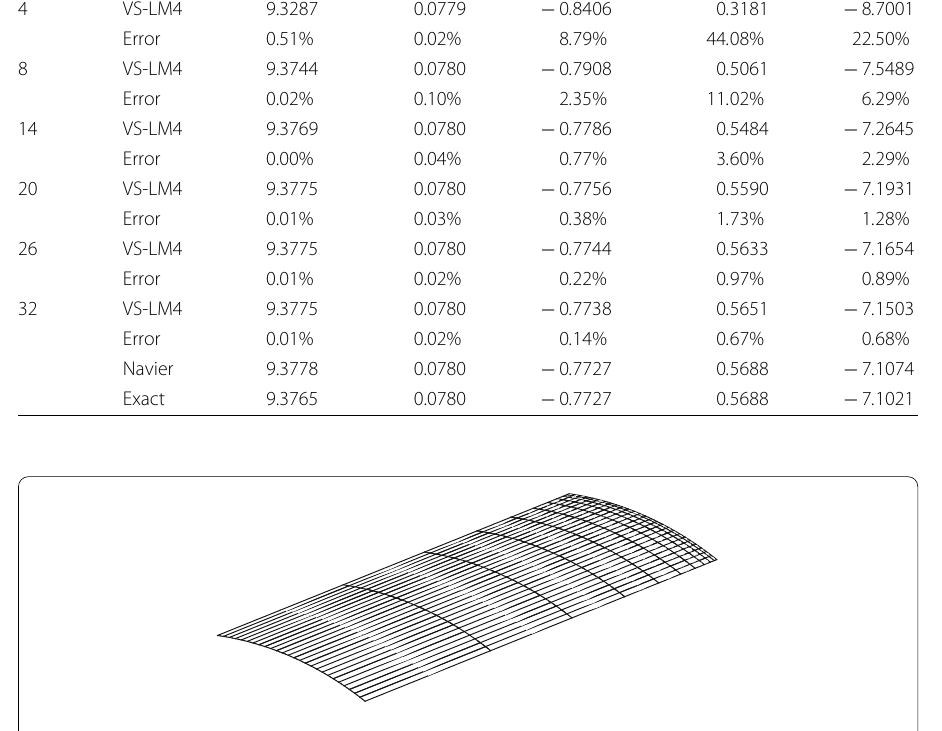
Fig. 3 Mesh 26 × 10 with a space ratio 50 for one quarter of the shell panel— φ = π/ 3– R =